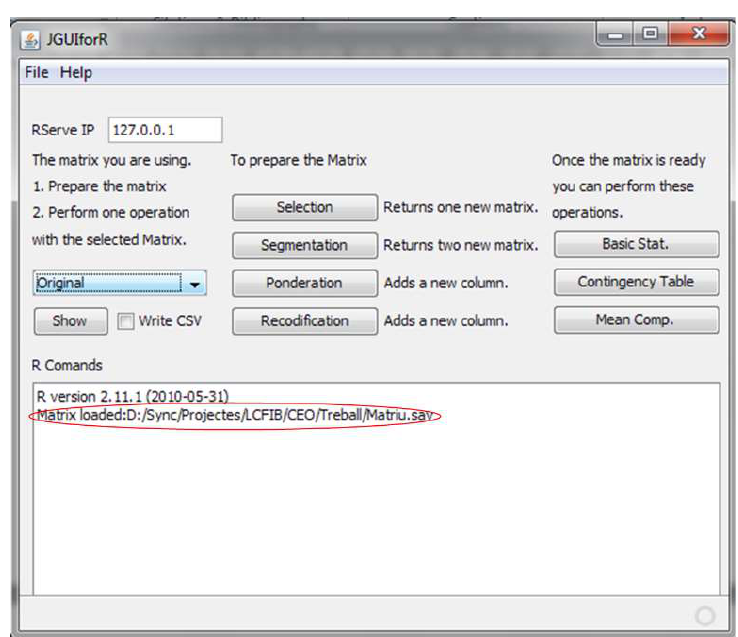
Figure 7. Matrix successfully loaded. All the options are now activated, and the user can start working with the matrix.